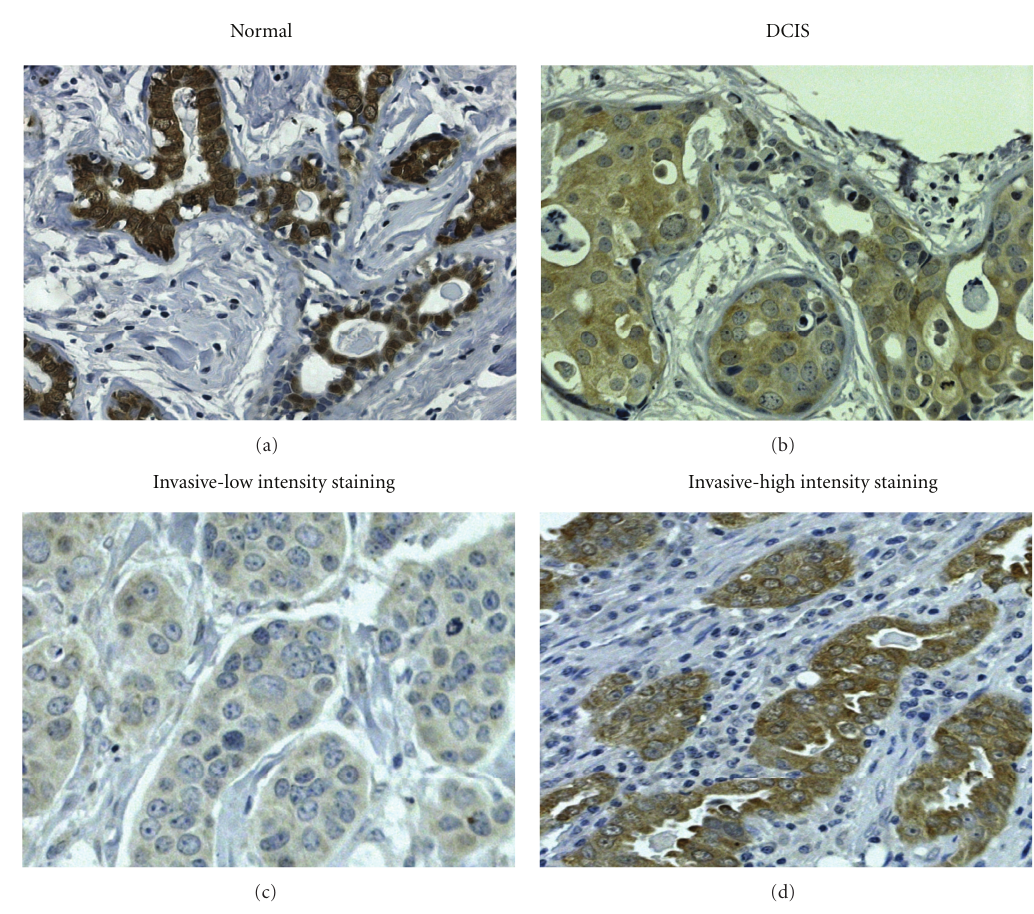
Figure 4: PAD2 IHC staining of the normal human mammary gland, a DCIS lesion, and invasive carcinomas. Nuclear staining intensity is reduced in most invasive tumors while a subset of these tumors retains strong PAD2 staining. (Magnification 200x).